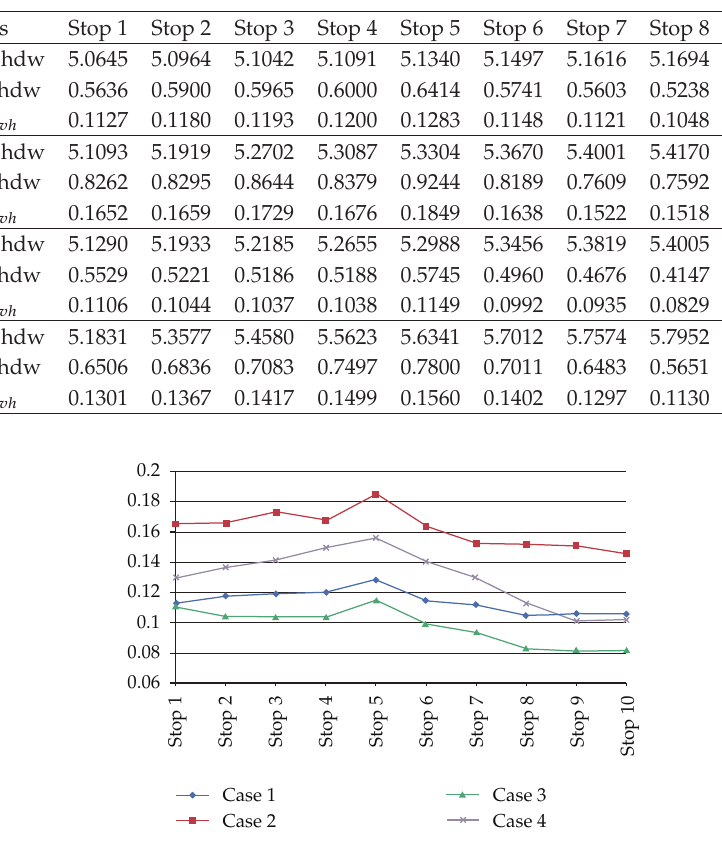
Table 3: The observed average headway, standard deviation of headways, and coe ffi cient of variation of headways.